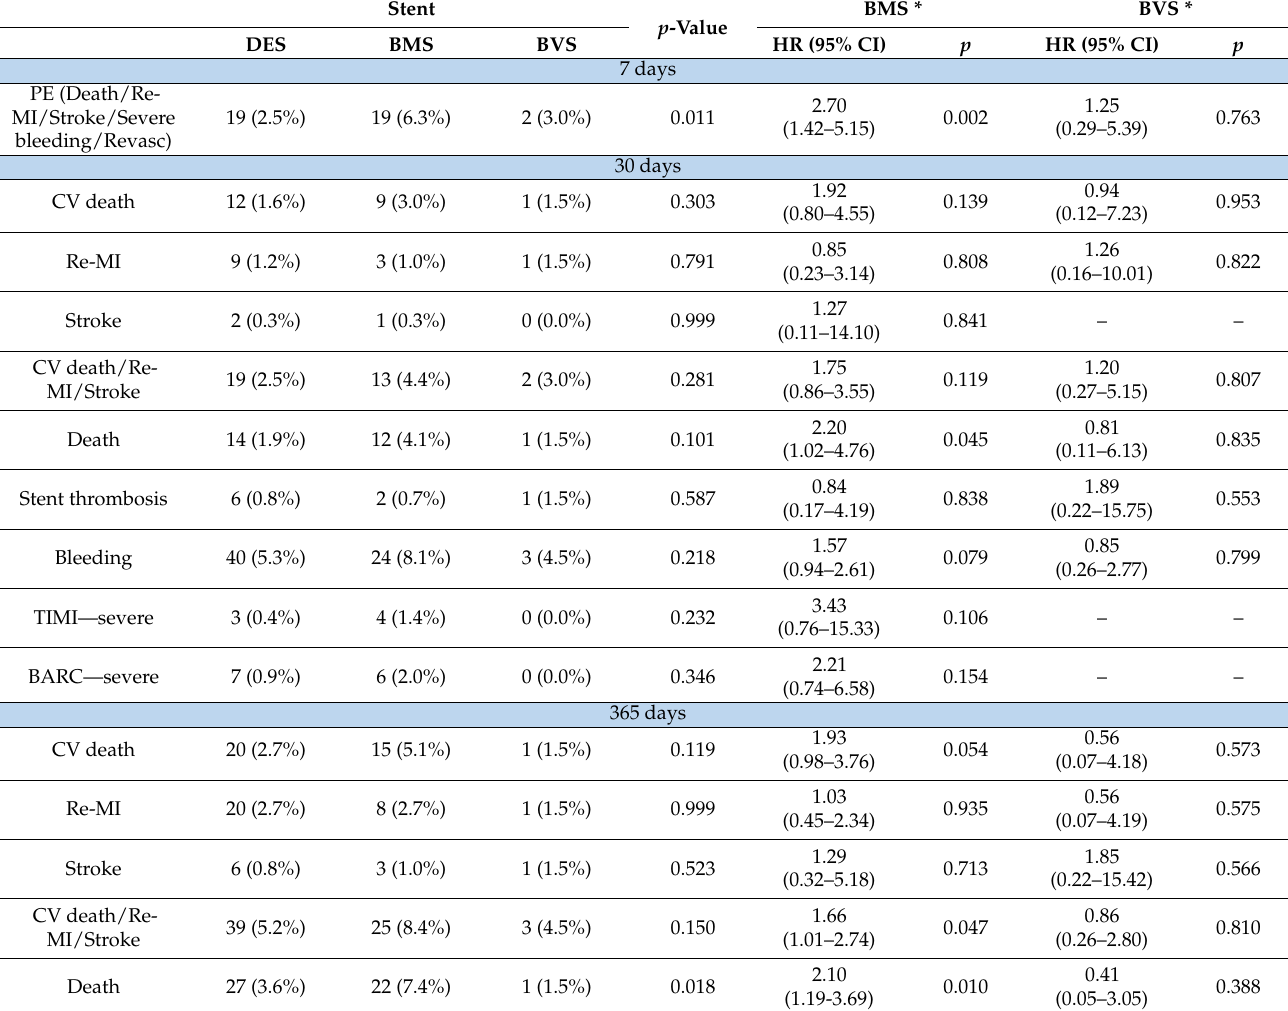
Table 2. Comparison of endpoint occurrence among patient groups by stent type (DES vs. BMS vs. BVS). Stent BMS * BVS p -Value